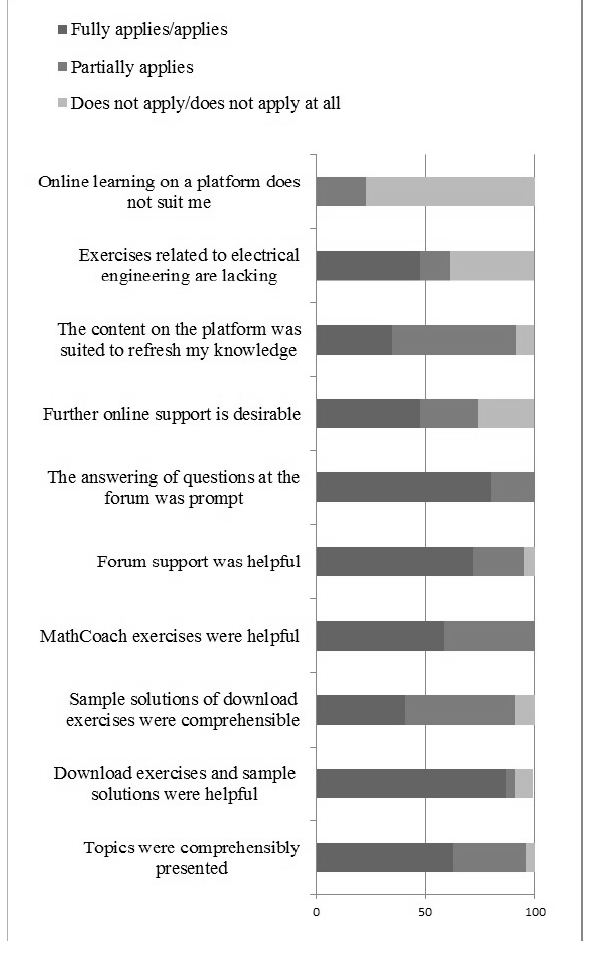
Figure 8. Category: learning